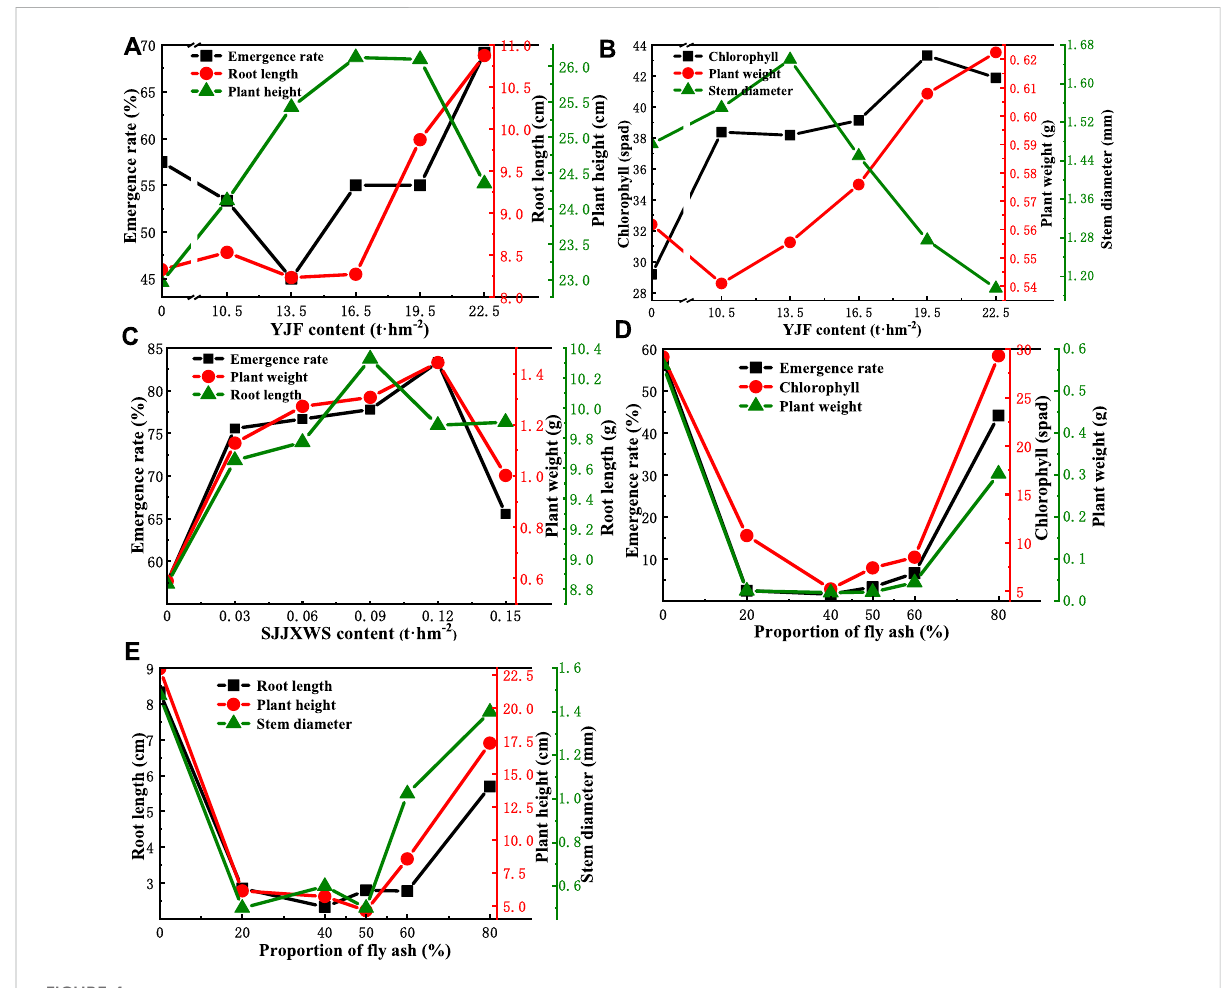
FIGURE 4 Agronomic characteristics of the plants in the functional soils used in this